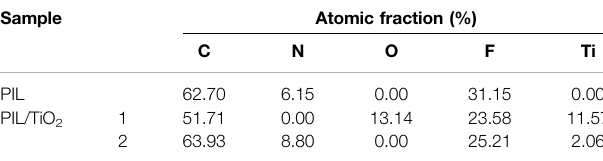
TABLE 1 | Atomic fraction of the samples determined by EDS analysis. Sample Atomic fraction